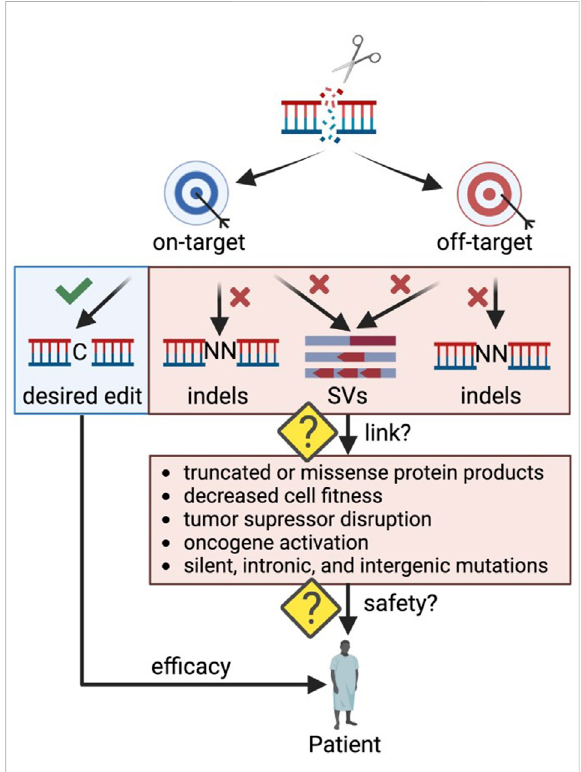
FIGURE 1 Outstanding questions to ensure safety in